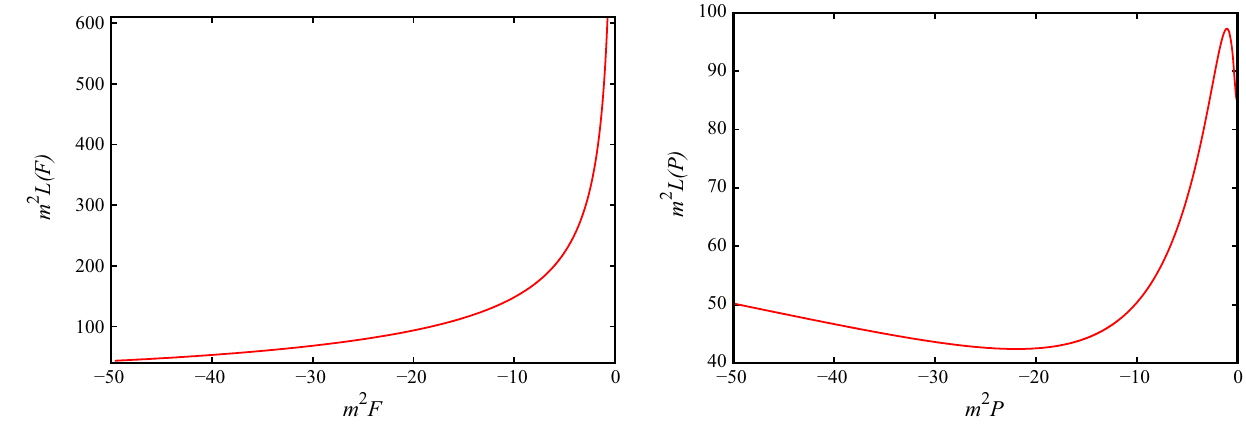
Fig. 10 Behavior of the electromagnetic Lagrangian in terms of the electromagnetic scalar and the auxiliary field P for mc 1 = 1 and q = 0 . 7